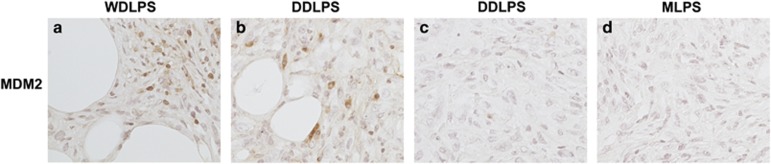
Immunohistochemical analysis of MDM2 in WDLPS, DDLPS and MPLS subtypes. MDM2 protein is expressed at very high levels in WDLPS and DDLPS sections in areas with lipoblasts (a and b) and absent in DDLPS sections lacking lipoblasts (c) and MLPS (d)